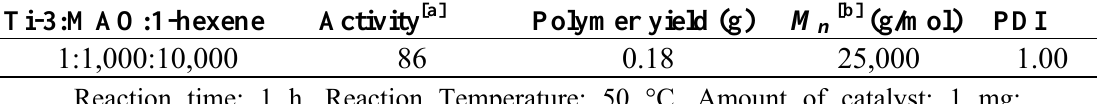
Table 2. Homopolymerization of 1-hexene using Ti-3 .